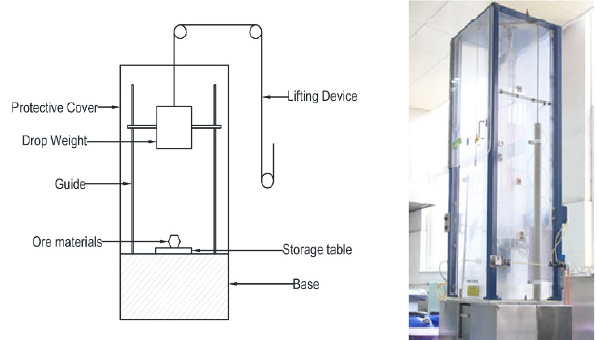
Figure 4. Schematic of the drop weight test machine.